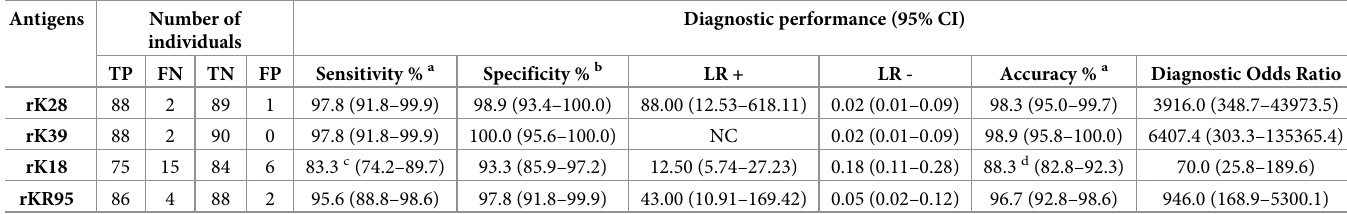
Table 1 presents the diagnostic performance obtained by rK28-ELISA, rK39-ELISA, rK18-ELISA, and rKR95-ELISA. Considering the 90 VL patients (panel 1), a significant differ- ence was obtained in sensitivity (Cochran’s Q test: p < 0.0001). Lower values were obtained by rK18-ELISA (83.3%; 95% CI: 74.2%-89.7%) compared with rK28-ELISA (97.8%; 95% CI: